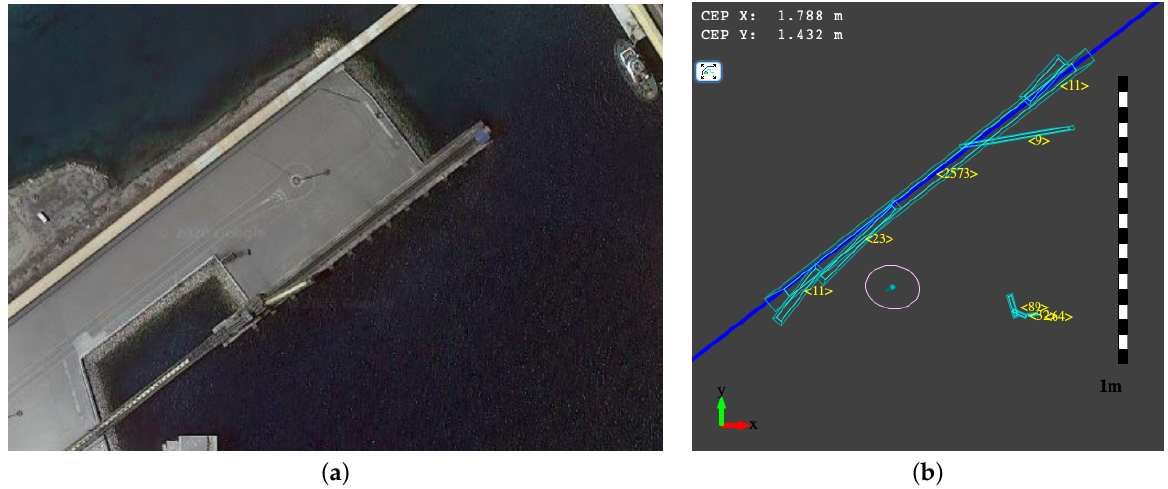
Figure 14. ( a ) Harbor dock scenario and ( b ) the fuzzy segment representation of the environment surrounding the vehicle.